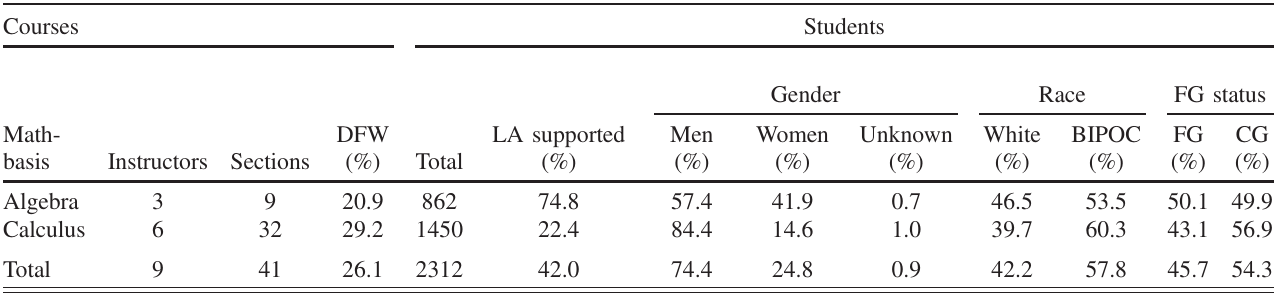
TABLE I. Descriptive statistics for the first semester courses in each of the two introductory physics sequences.